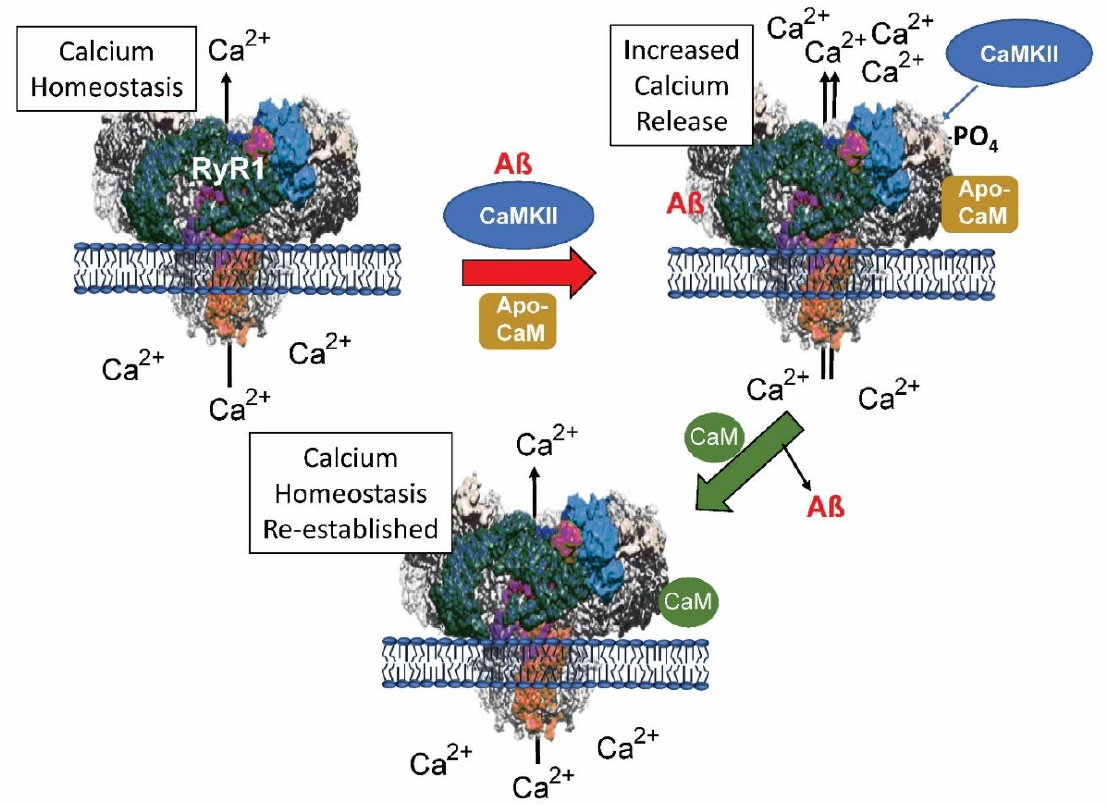
Figure 4. The effects of calmodulin (CaM) and amyloid beta (Aβ) on calcium release via RyR1 from the endoplasmic reticulum. Binding of Aβ or phosphorylation of RyR1 by the calcium/CaM-dependent kinase II (CaMKII) can lead to increase calcium release from the endoplasmic. Binding to calcium-free apo-CaM can also generate higher levels of calcium release. Calcium-bound CaM slows calcium release in normal cells and as projected here, could possibly restore dysregulated levels to